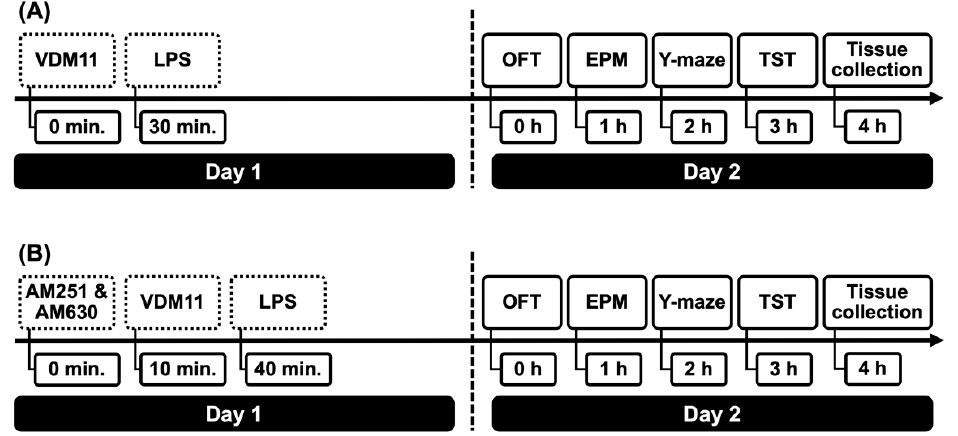
Figure 1. ( A ) Mice received different doses of VDM11 followed with LPS. ( B ) Mice received